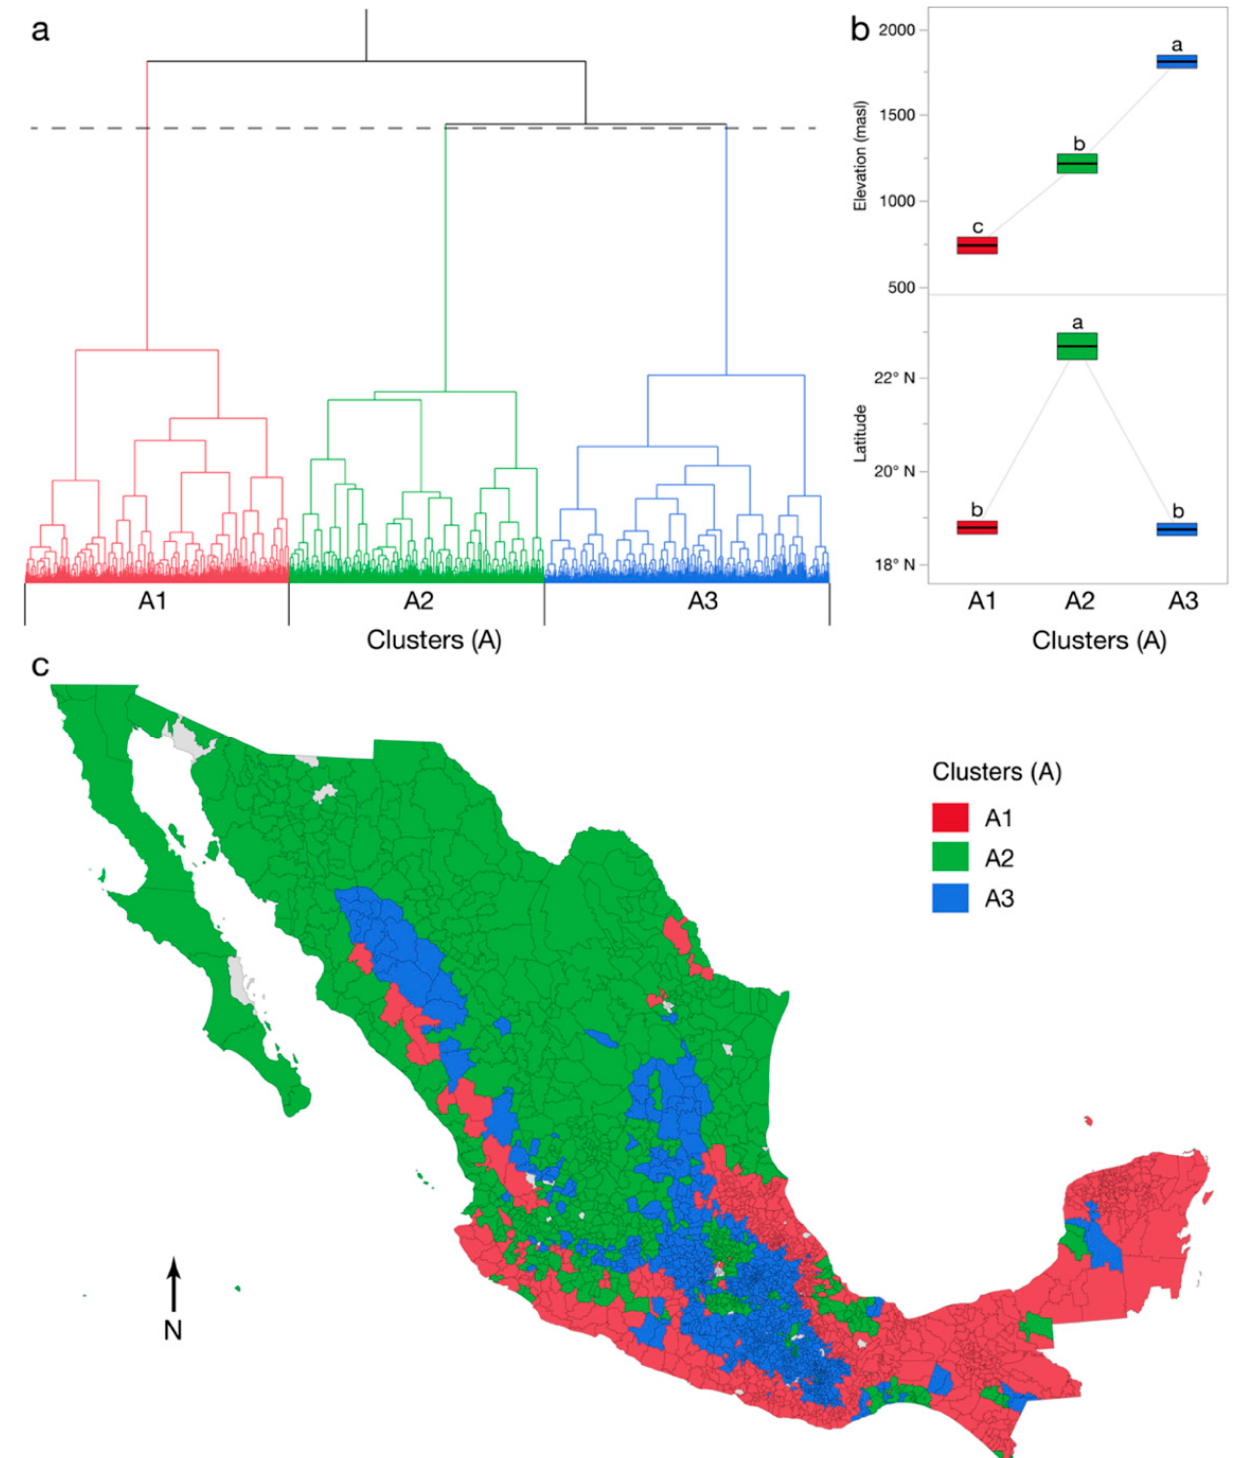
Figure 1. ( a ) Dendrogram of cluster (A) solution (CCC = 18.81). ( b ) Differences in mean elevation and latitude shown with 95% means confidence intervals with different letters representing statistical significance as determined by Kruskal–Wallace and Dunn’s post hoc tests. ( c ) Mapped clusters, with omitted municipalities shaded gray.